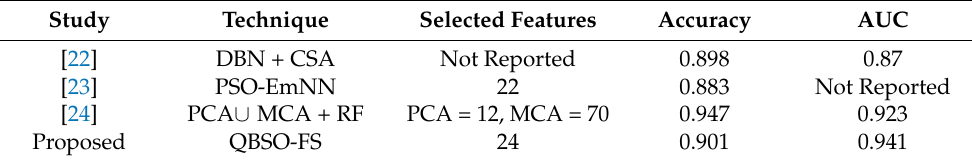
Table 8. Proposed model comparative analysis with the current state-of-the-art methods using the Z-Alizadeh Sani dataset.